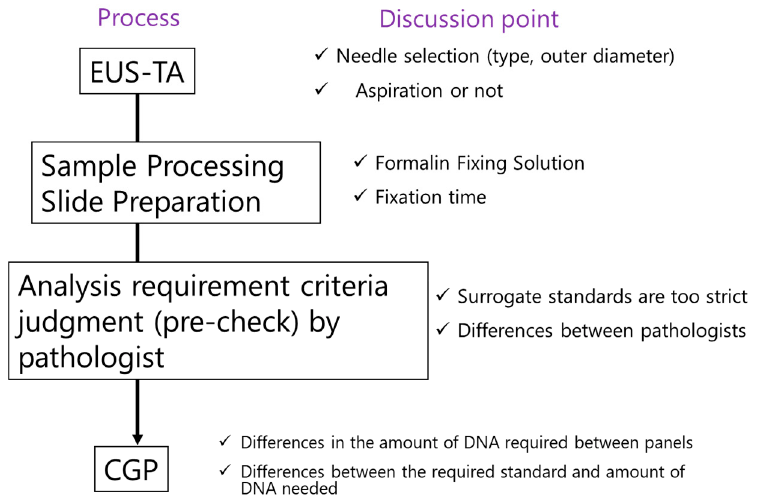
Figure 1. Process from EUS-TA to CGP analysis and discussion points. CGP: comprehensive genome profile; EUS-TA: endoscopic ultrasound-guided tissue acquisition.